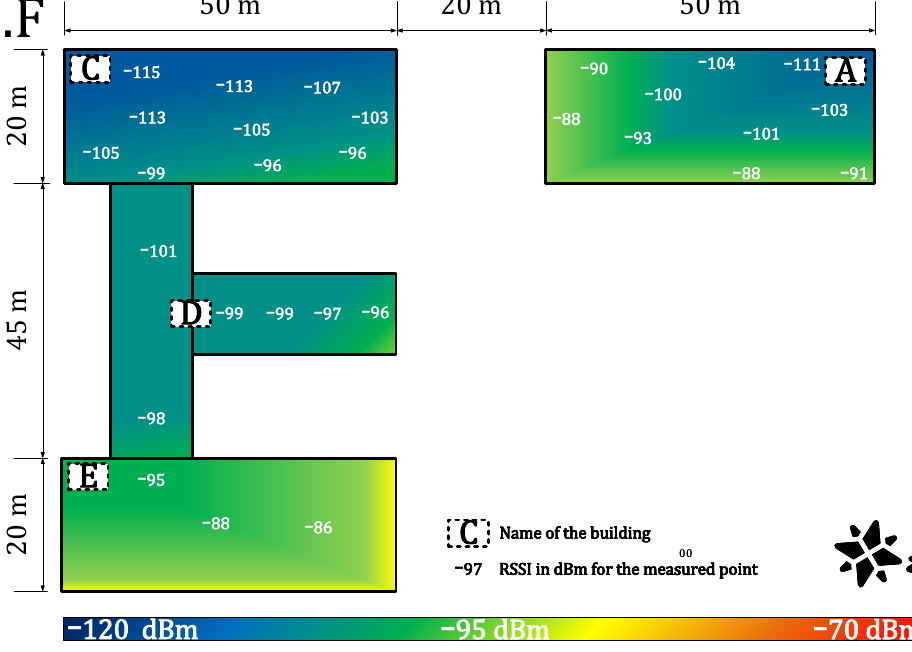
Figure 9. Private network coverage and signal propagation on the fifth